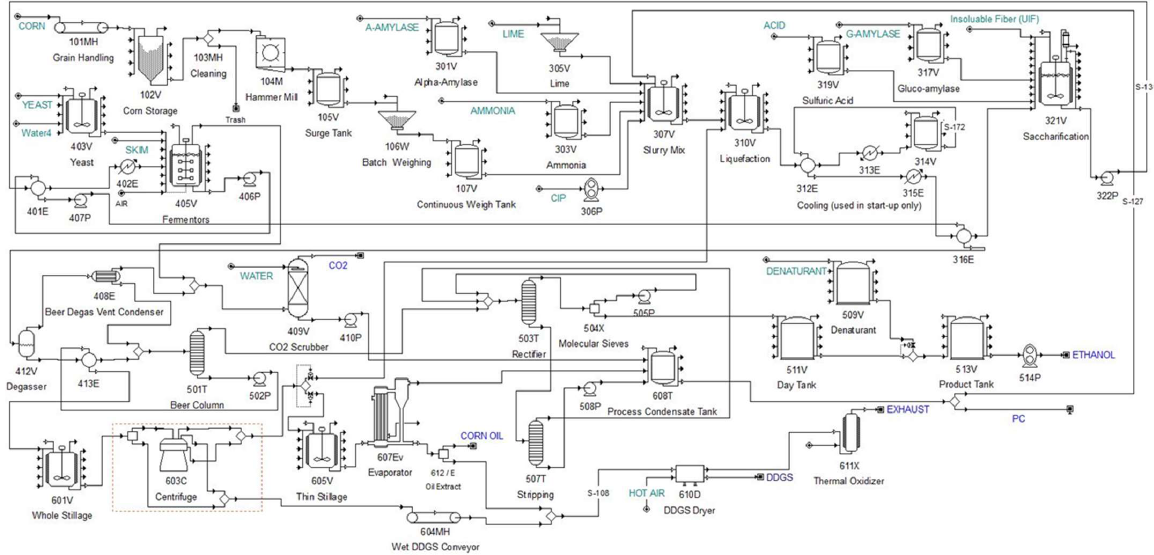
Figure 1. Process flow diagram used to model integrated corn-EAEP ethanol fermentation processing. Note that soy skim is added directly to the fermentor, but soy insoluble fiber is added to the saccharification step immediately prior to fermentation. This SuperPro model was adapted from [8,9].